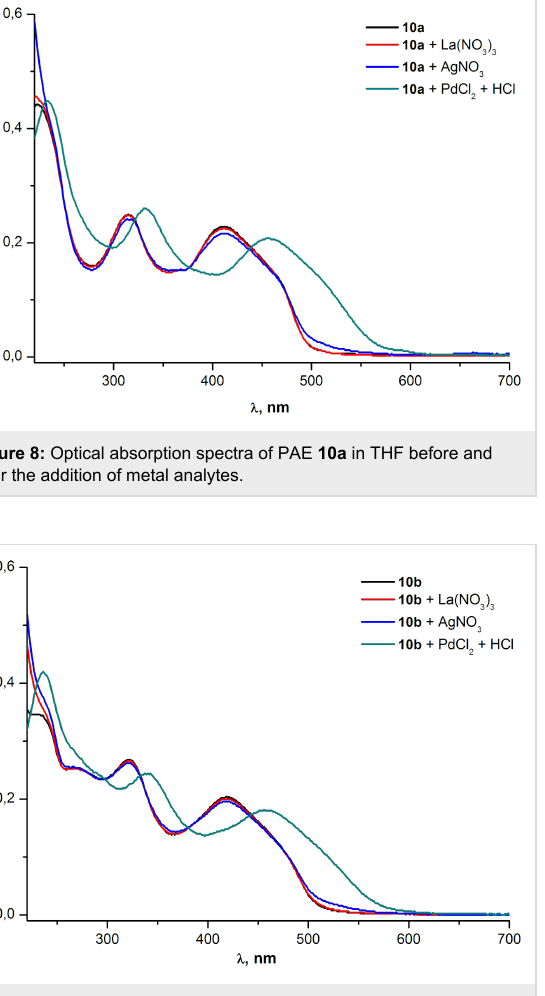
Figure 9: Optical absorption spectra of PAE 10b in THF before and after the addition of metal analytes.